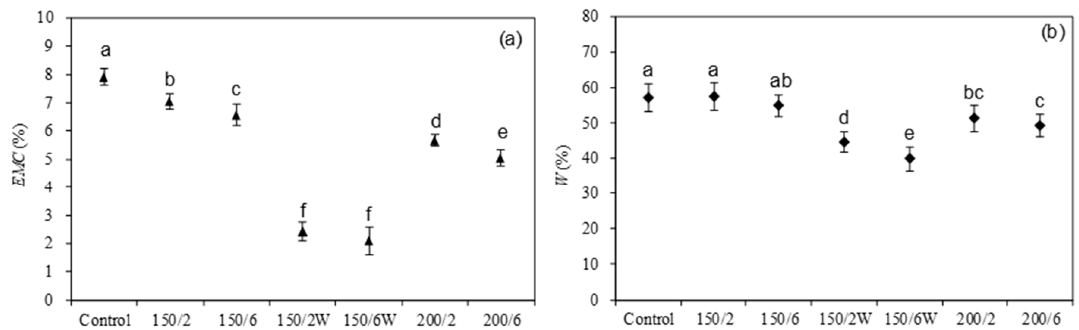
Figure 1. EMC and water absorption ratio ( W ) of control and modified groups: water adsorption ( a ) and water absorption ( b ). Bars showing different letters indicate significant difference ( p < 0.05) according to Duncan’s multiple range tests.